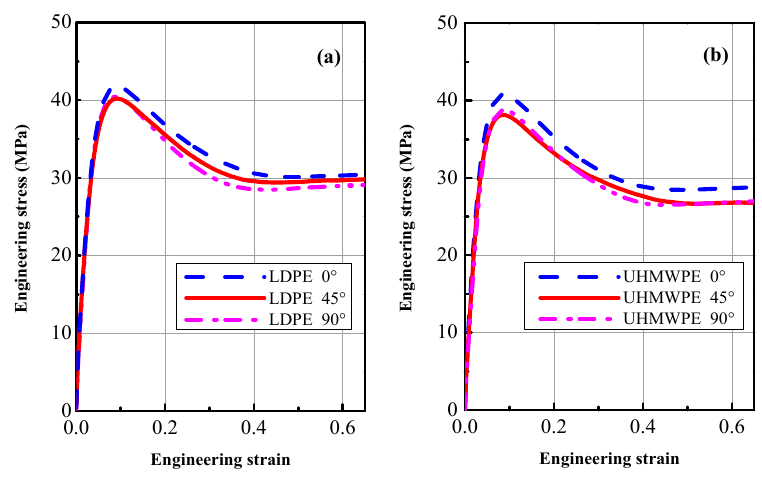
Figure 6. Engineering stress-strain curves of LDPE and UHMWPE at 0.001 s − 1 strain rate for three directions relative to extrusion direction.